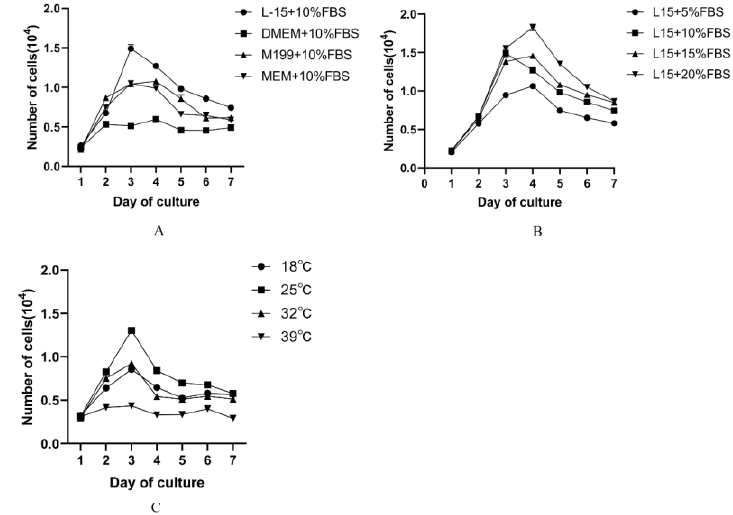
Figure 2. Growth kinetics of TAH-11cell line at Passage 50: ( A ) effects on cell growth of different medium at 25 °C; ( B ) effects of different concentrations of FBS in L-15 medium on cell growth at 25 °C; ( C ) effects of different culture temperatures on cell growth in L-15 medium containing 10% FBS.